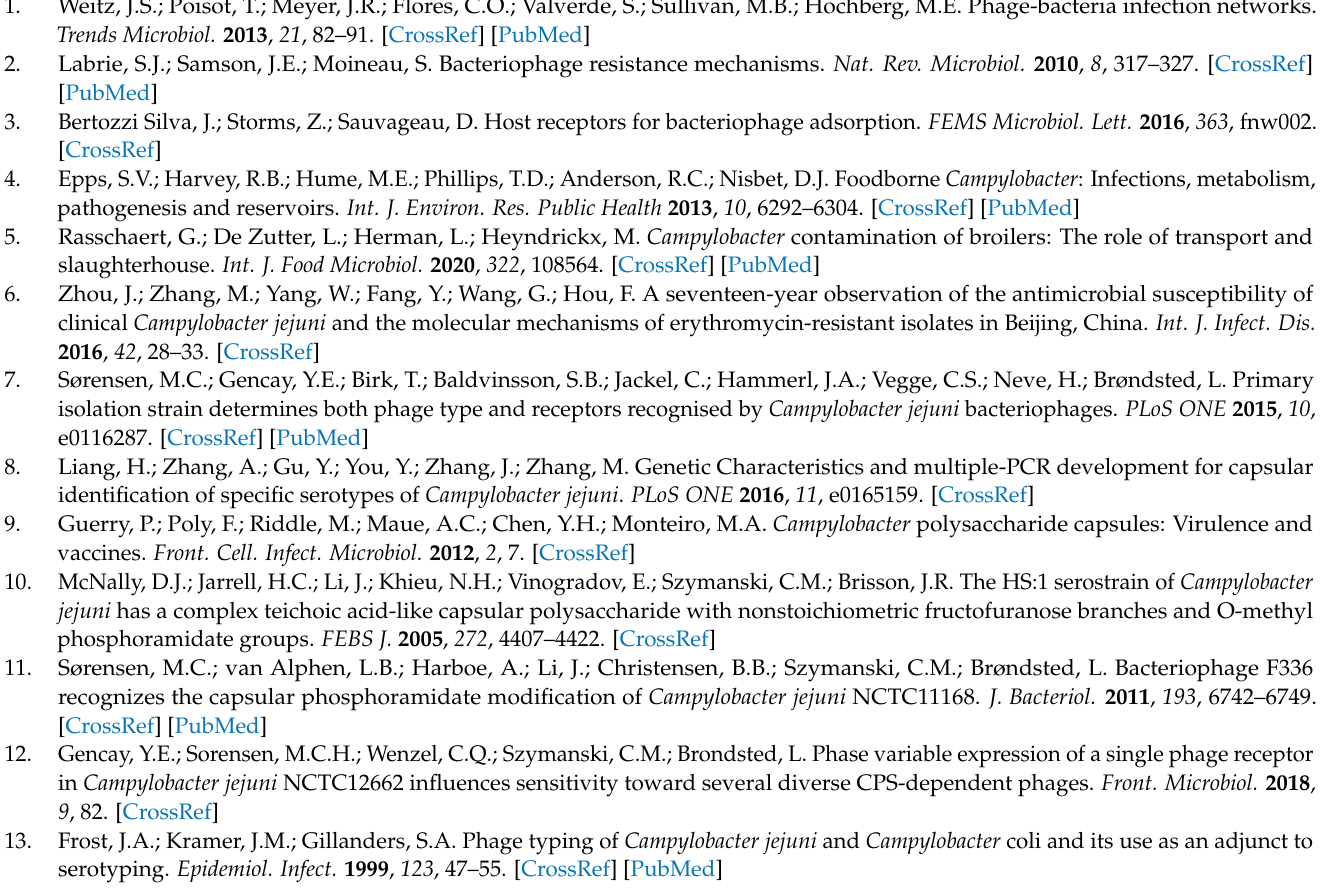
Table S3: Primers used in this study; Table S4: C. jejuni NCTC12662 genes with SNPs after phage CP39